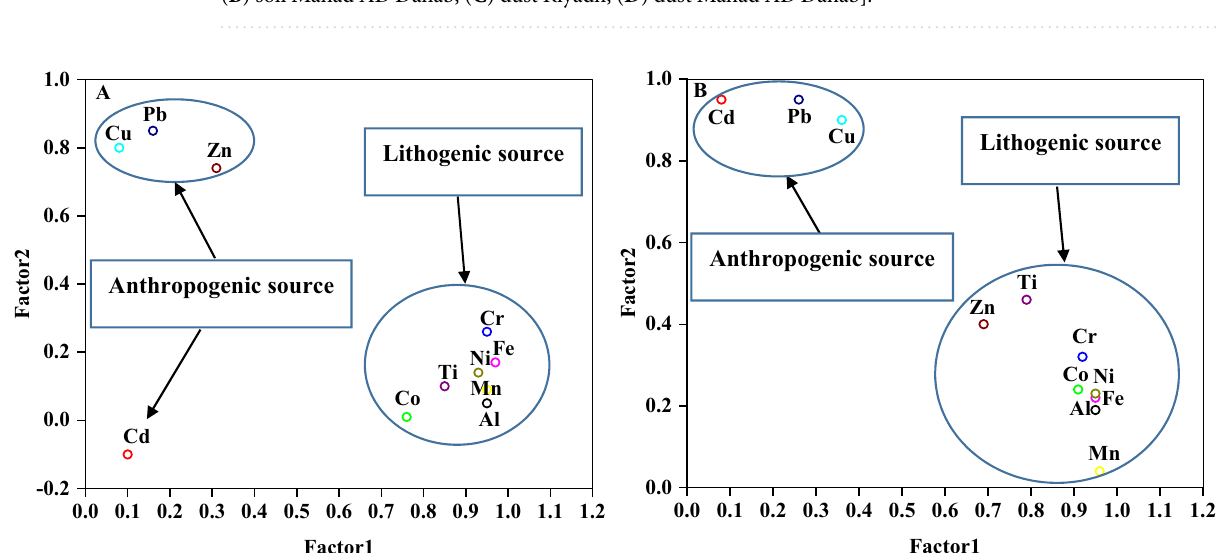
Figure 3. 2D plot of the PCA for heavy metals in dust samples of Riyadh ( A ) and Mahad AD’Dahab ( B